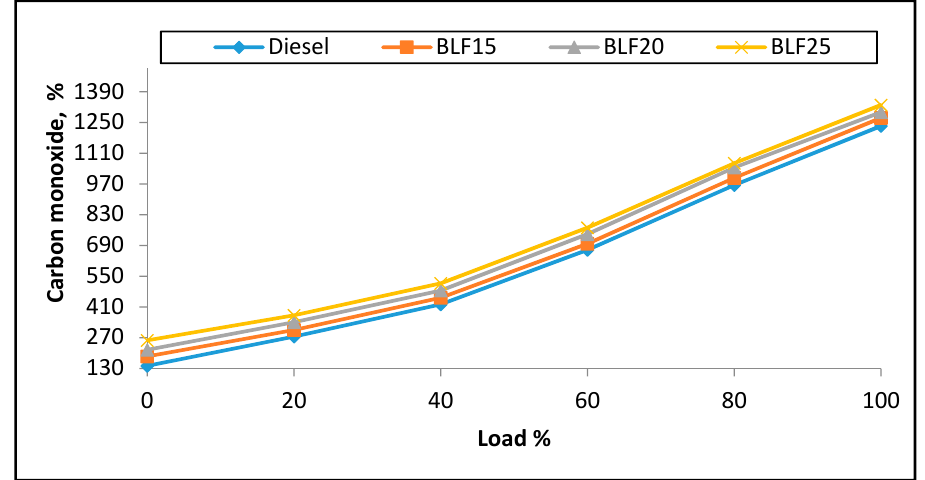
Figure 12. Variations of NO x vs. load percent.